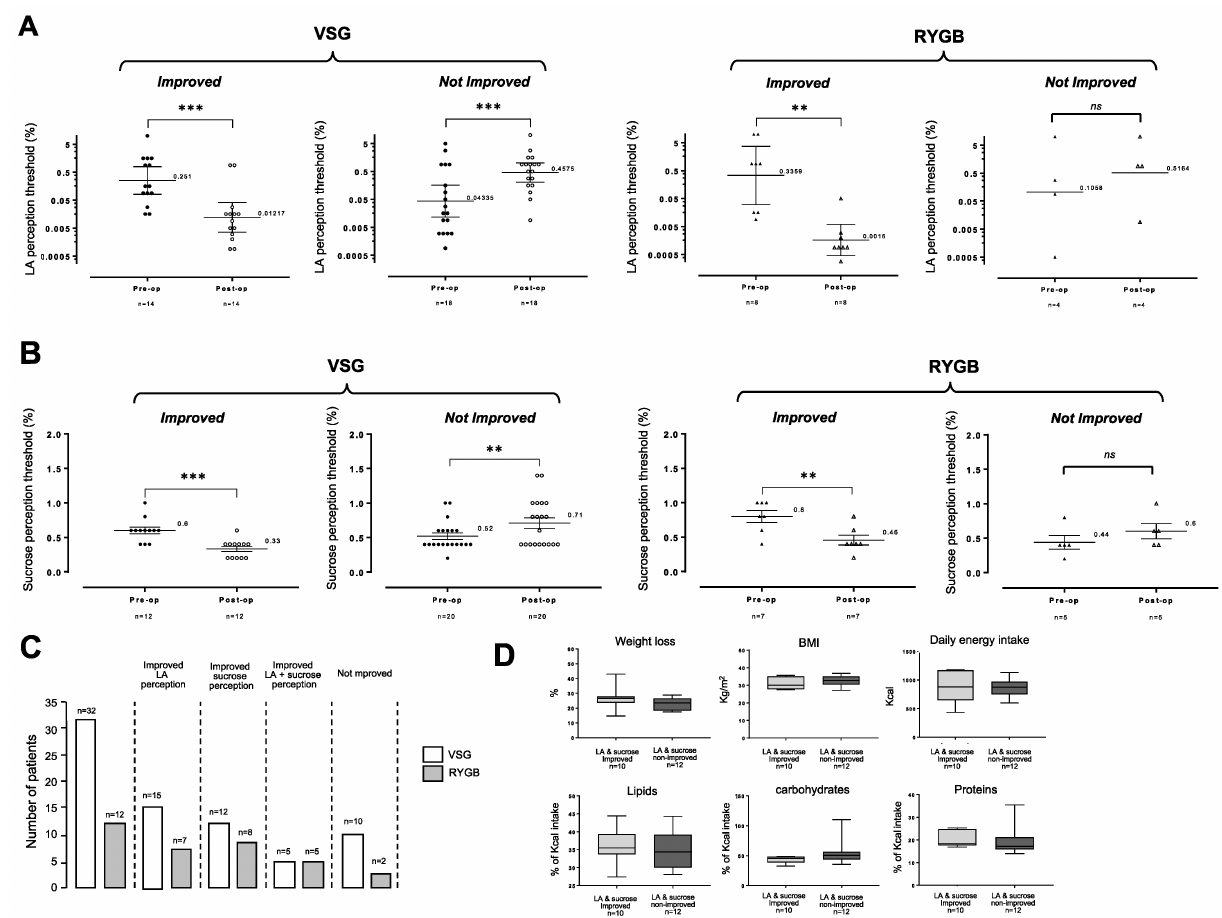
Figure 3. ( A ) Comparison of linoleic acid (LA) orosensory perception thresholds before and 6 months after vertical sleeve gastrectomy (VSG) or Roux-en-Y gastric bypass (RYGB) in improved and nonimproved patients. Ascending concentrations of LA (from 0.00028% to 5% LA with 0.25 log units space, wt/wt) were assessed. ( B ) Comparison of linoleic acid (LA) orosensory perception thresholds before and 6 months after vertical sleeve gastrectomy (VSG) or Roux-en-Y gastric bypass (RYGB) in improved and nonimproved patients. Ascending concentrations of sucrose (from 0.2% to 1.6% sucrose with increments of 0.2 g, wt/wt) were assessed. Geometric means, comparisons of perception thresholds before vs. after surgery were performed using a paired Wilcoxon–Pratt test. ( C ) Repartition of improved and nonimproved patients. ( D ) Post-operative comparison of weight loss, body mass index (BMI) and reported energy intake and composition using the four-day food recall in LA/sucrose-improved and nonimproved patients. **, p < 0.01; ***, p < 0.001; ns,